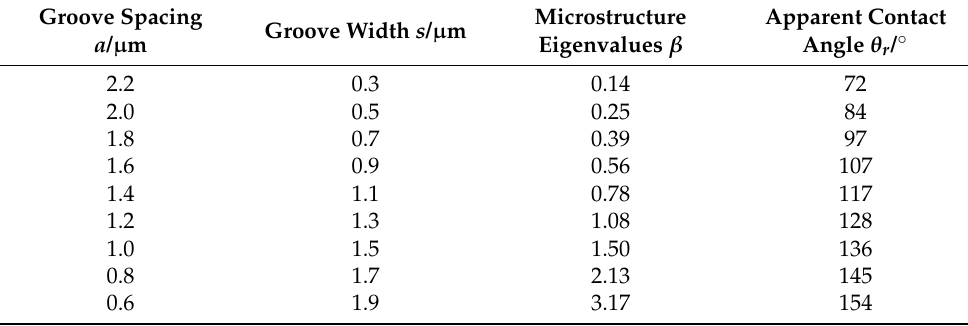
Table 1. The apparent contact angle under different microstructural parameters. Groove Spacing Groove Width s / µ m a / µ m